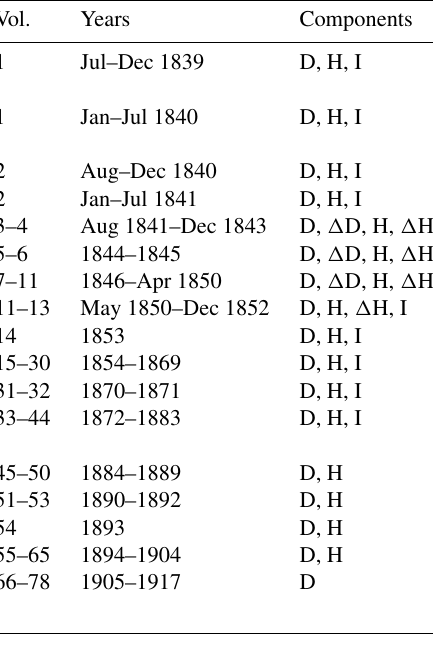
Table 1. Summary of daily measurements published in the yearbooks Magnetische und meteorologische Beobachtungen zu Prag . The time of the measurements is listed as the hour (in 24h time), except where the half-hour is indicated, and corresponds to Göttingen civic time,